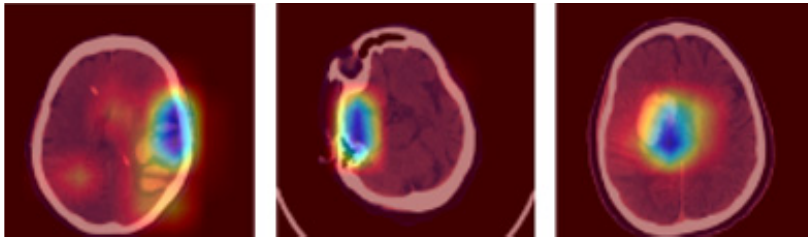
Figure 3. Sample segmented 3D brain scans.